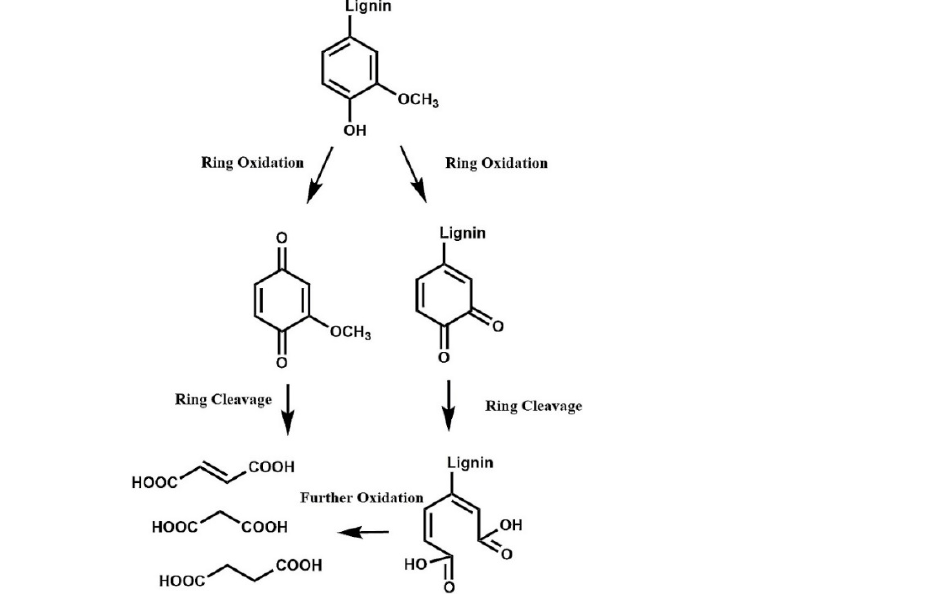
Figure 10. Oxidation of lignin through ring-opening reactions to yield C 4 dicarboxylic acids. (Reprinted from [64] Copyright 2018, with permission from Elsevier.)